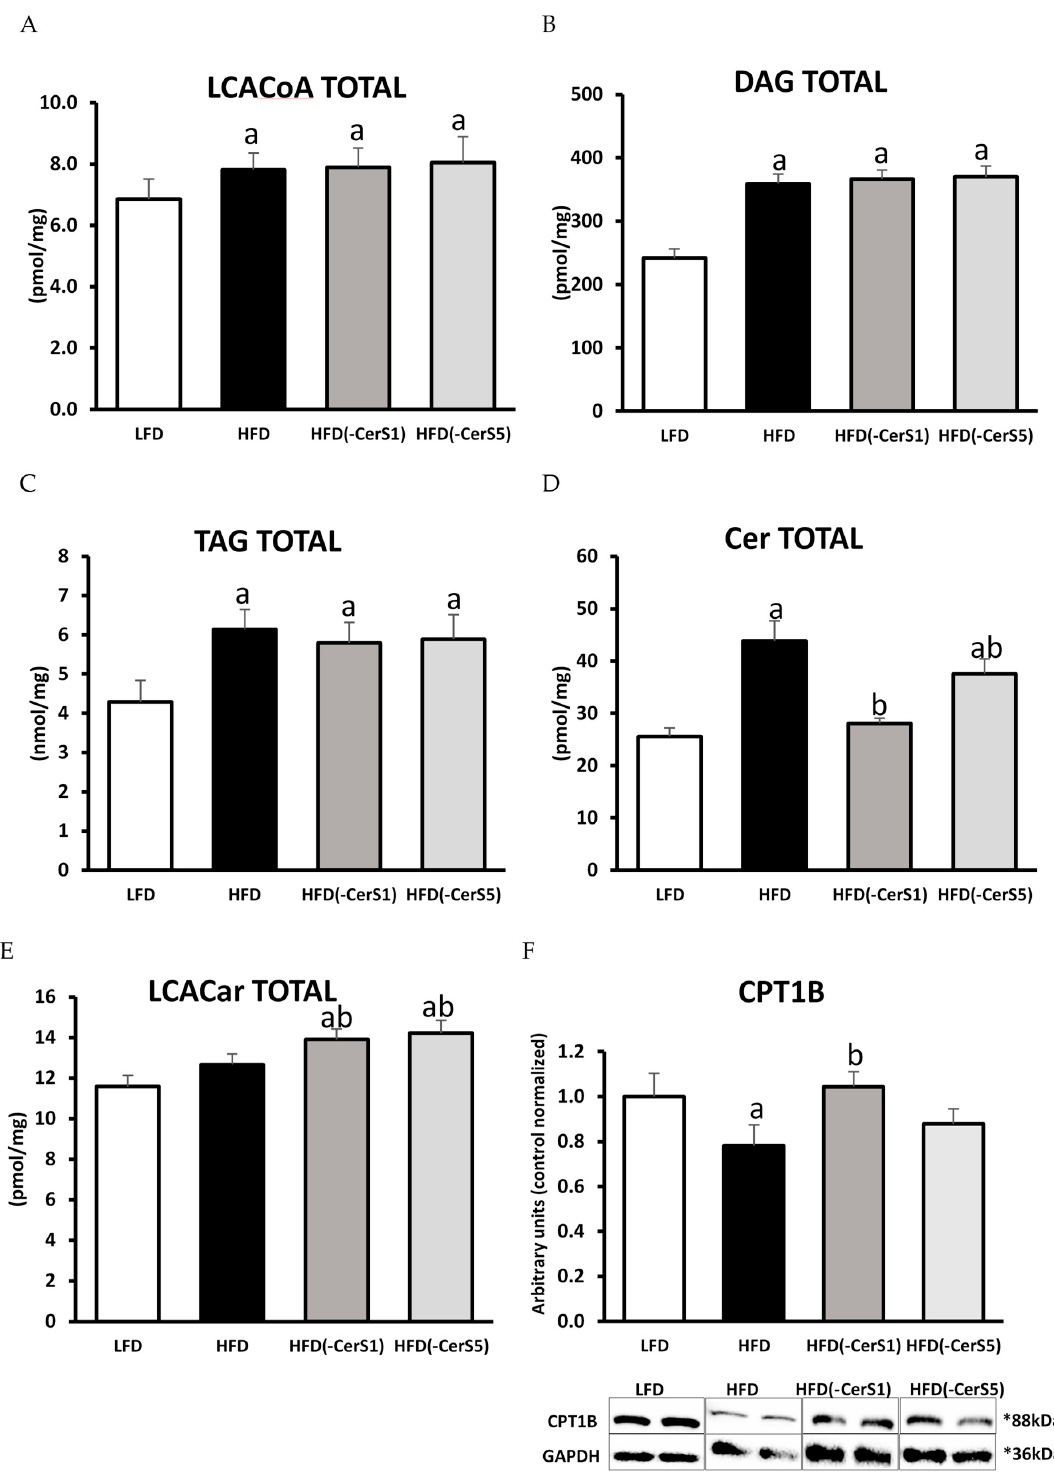
Figure 4. The impact of CerS1 and CerS5 silencing on the content of bioactive lipids, acyl-carnitines, and the protein expression of CPT1B in gastrocnemius muscle of HFD-fed mice: Panel A —total content of LCACoA; Panel B —total content of DAG; Panel C —total content of TAG; Panel D —total Cer content; Panel E —total content of acyl-carnitines, Panel F —protein of CPT1B. Values are mean ±SD ( n = 8 per group); a— p < 0.05 vs. LFD; b— p < 0.05 vs. HFD; significance by ANOVA; LFD-low-fat diet, HFD—high-fat diet. The observed molecular weight of indicated proteins is different to the theoretical one, as stated by the antibody manufacturer. Table 2. Impact of CerS1 and CerS5 gene silencing on the content of individual long-chain acyl- CoA’s in mouse gastrocnemius muscle of HFD-fed animals. Values are mean pmol/mg of tissue ± SD; n = 8 per group; a — p < 0.05 vs. LFD.